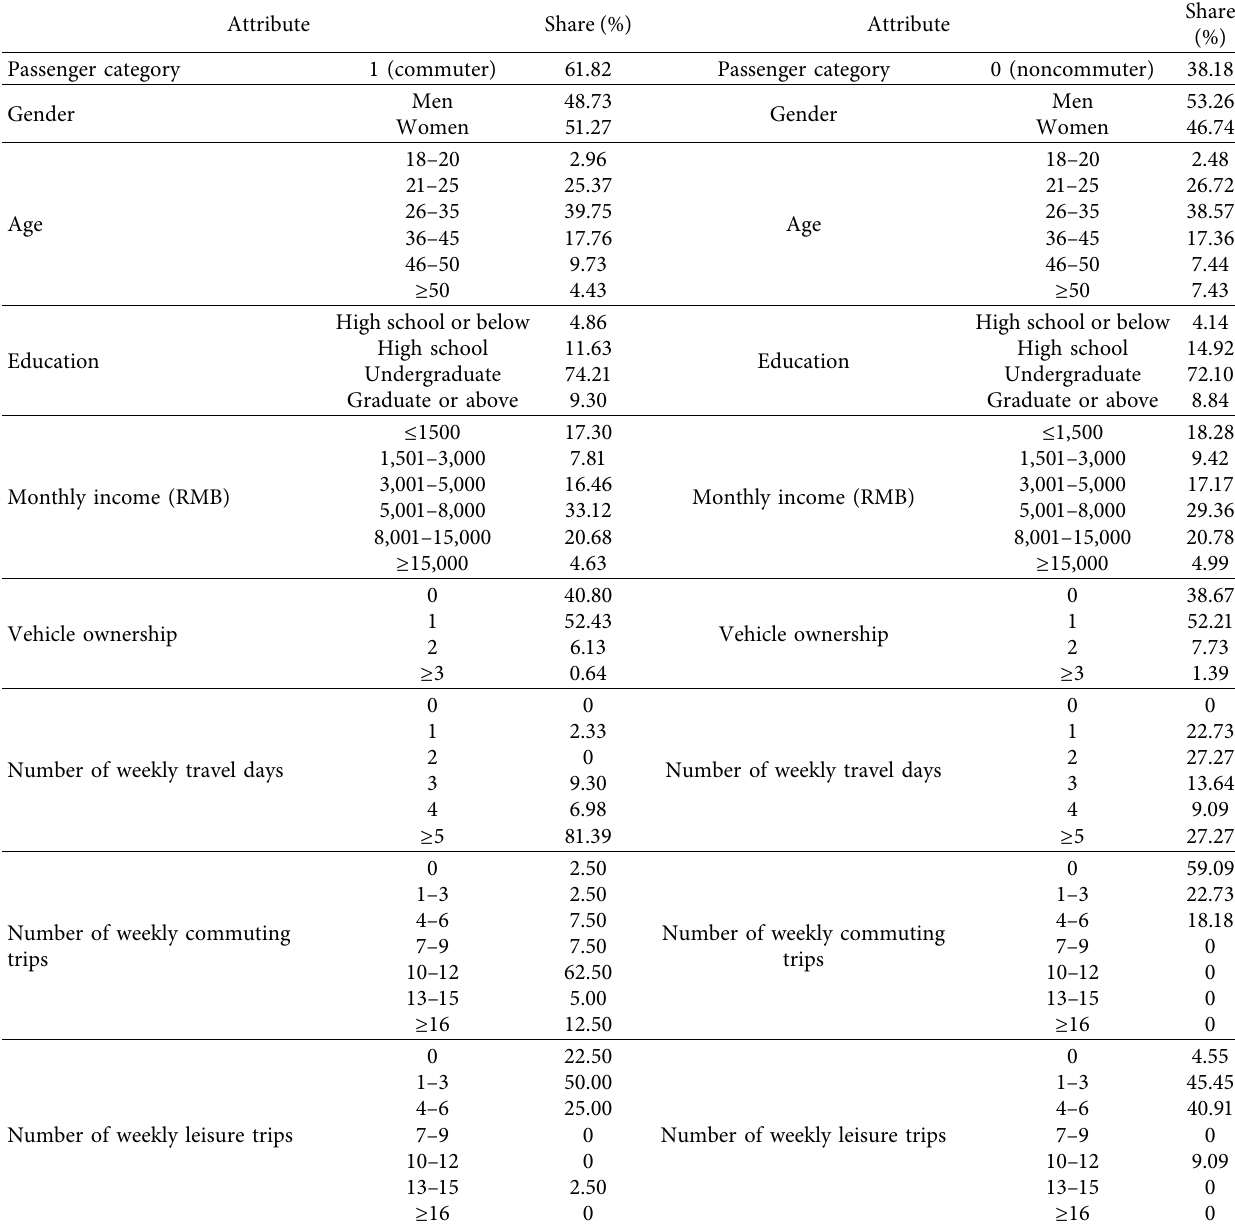
Table 4: Basic information